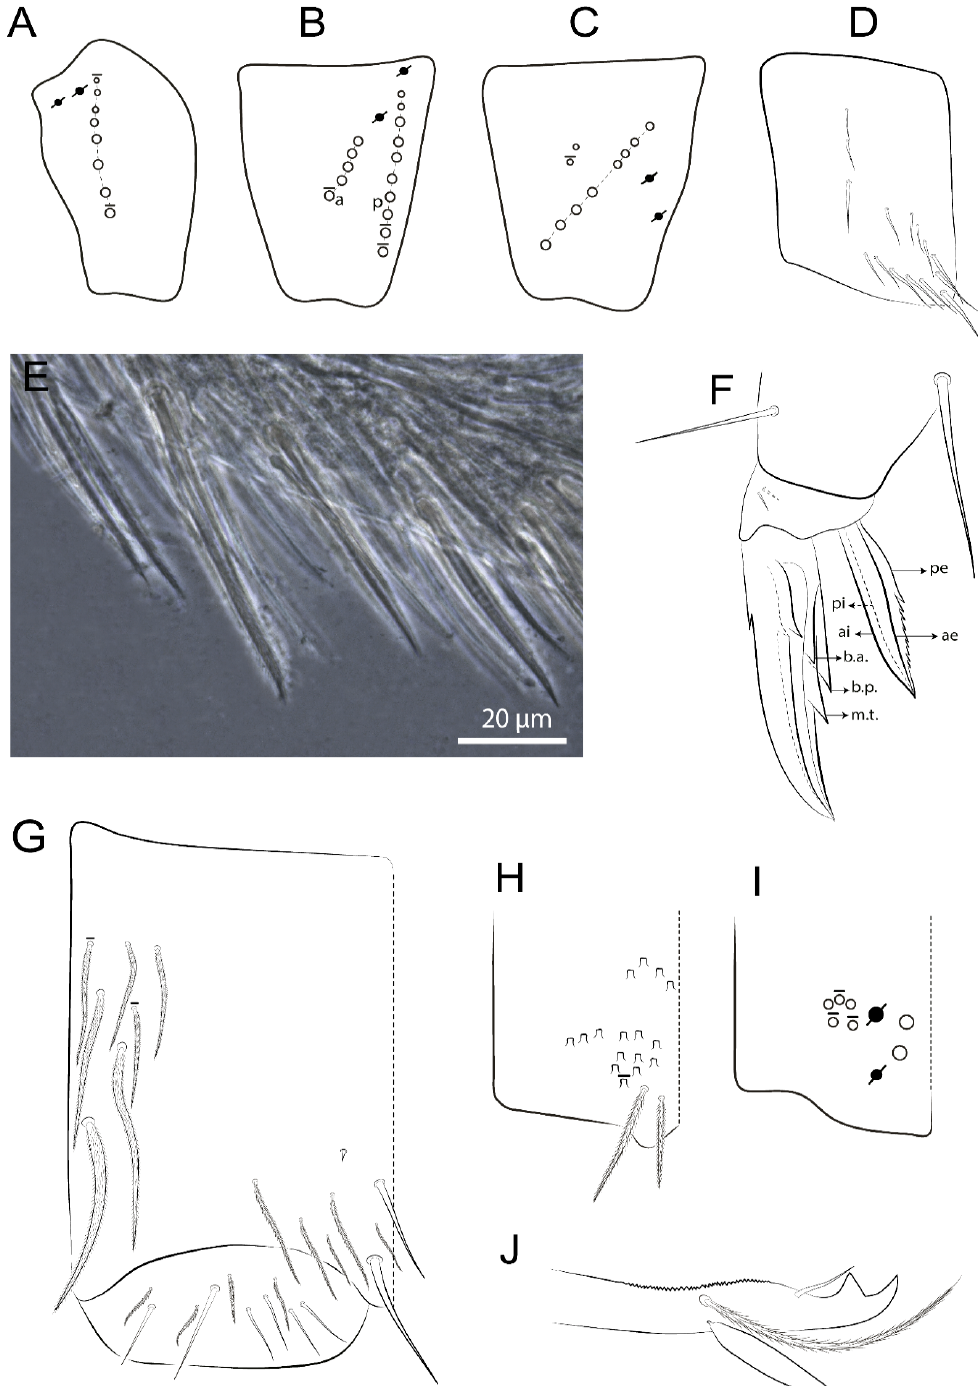
Figure 48. Pseudosinella diamantinensis sp. nov.: trunk appendages. ( A–C ) subcoxa I–III, respectively; ( D ) trochanteral organ; ( E ) modified chaeta of tibiotarsus III; ( F ) distal tibiotarsus and empodial complex III (anterior view); ( G ) collophore (lateral view); ( H ) distal part of manubrium (ventral view); ( I ) manubrial plate (dorsal view); ( J ) distal dens and mucro (inner view).